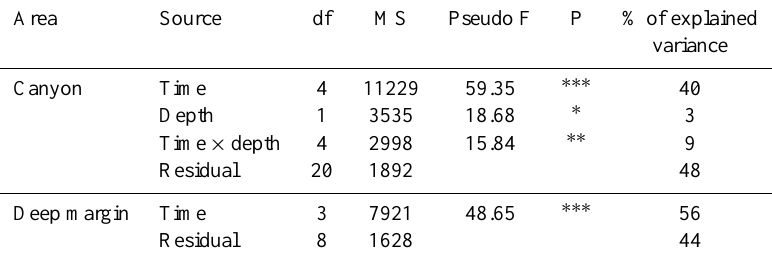
Table 5. Results of the PERMANOVA tests on nematode assemblage compositions in the sediments of the Cap de Creus Canyon and deep margin. Also reported is the percentage of variance explained by each source of variation and their interaction. df = degrees of